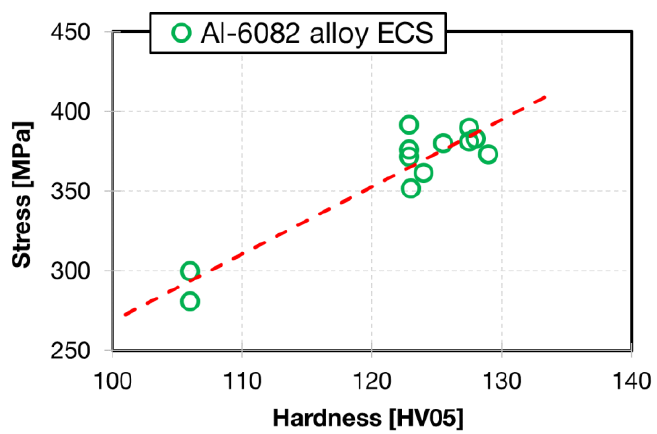
Figure 19. Relationship between hardness HV05 and TYS.